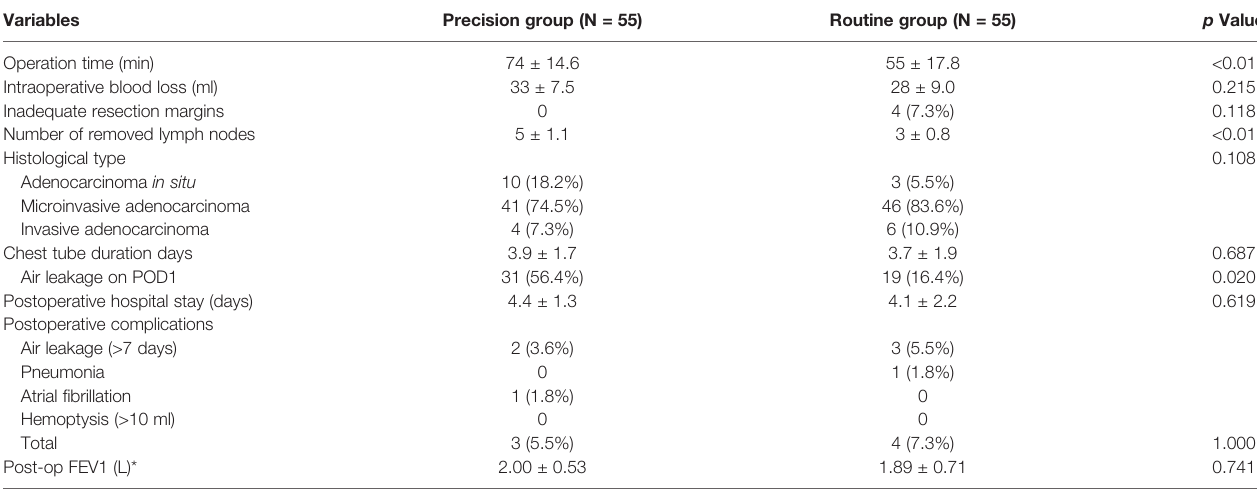
TABLE 3 | Intraoperative and postoperative characters of Precision group and Routine